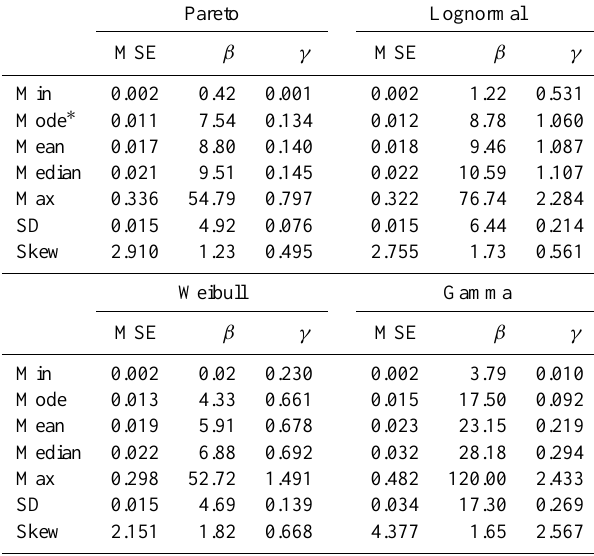
Table 3. Summary statistics from the fitting of the four distribution tails into the 15029 tail-samples of daily rainfall (expressed in mm).